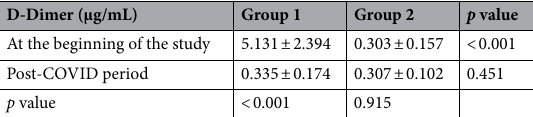
Table 2. D-dimer levels of the